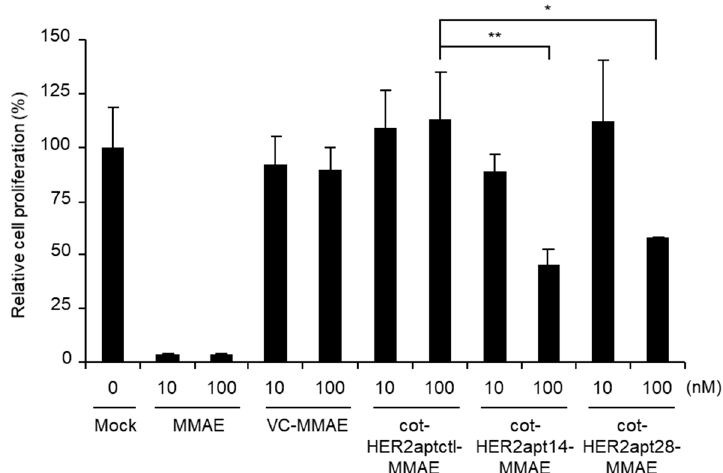
Figure 4. Cytotoxic effect of cot-HER2apt-MMAEs on NCI-N87 cells. The cells (1 × 10 4 ) were treated for 6 d with 10 or 100 nM free monomethyl auristatin E (MMAE), valine-citrulline (VC)-MMAE, cot-HER2aptctl-MMAE, cot-HER2apt14-MMAE, or cot-HER2apt28-MMAE. Cell viability was assessed using WST-1 proliferation assays. Data are shown as the mean ± standard deviation (SD). The p -value was calculated using Student t -test (* p < 0.05 and ** p < 0.01).